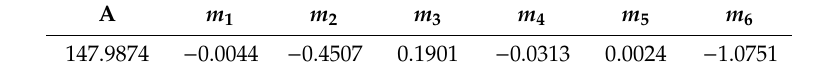
Table 4. Material parameters in the oHS equation.